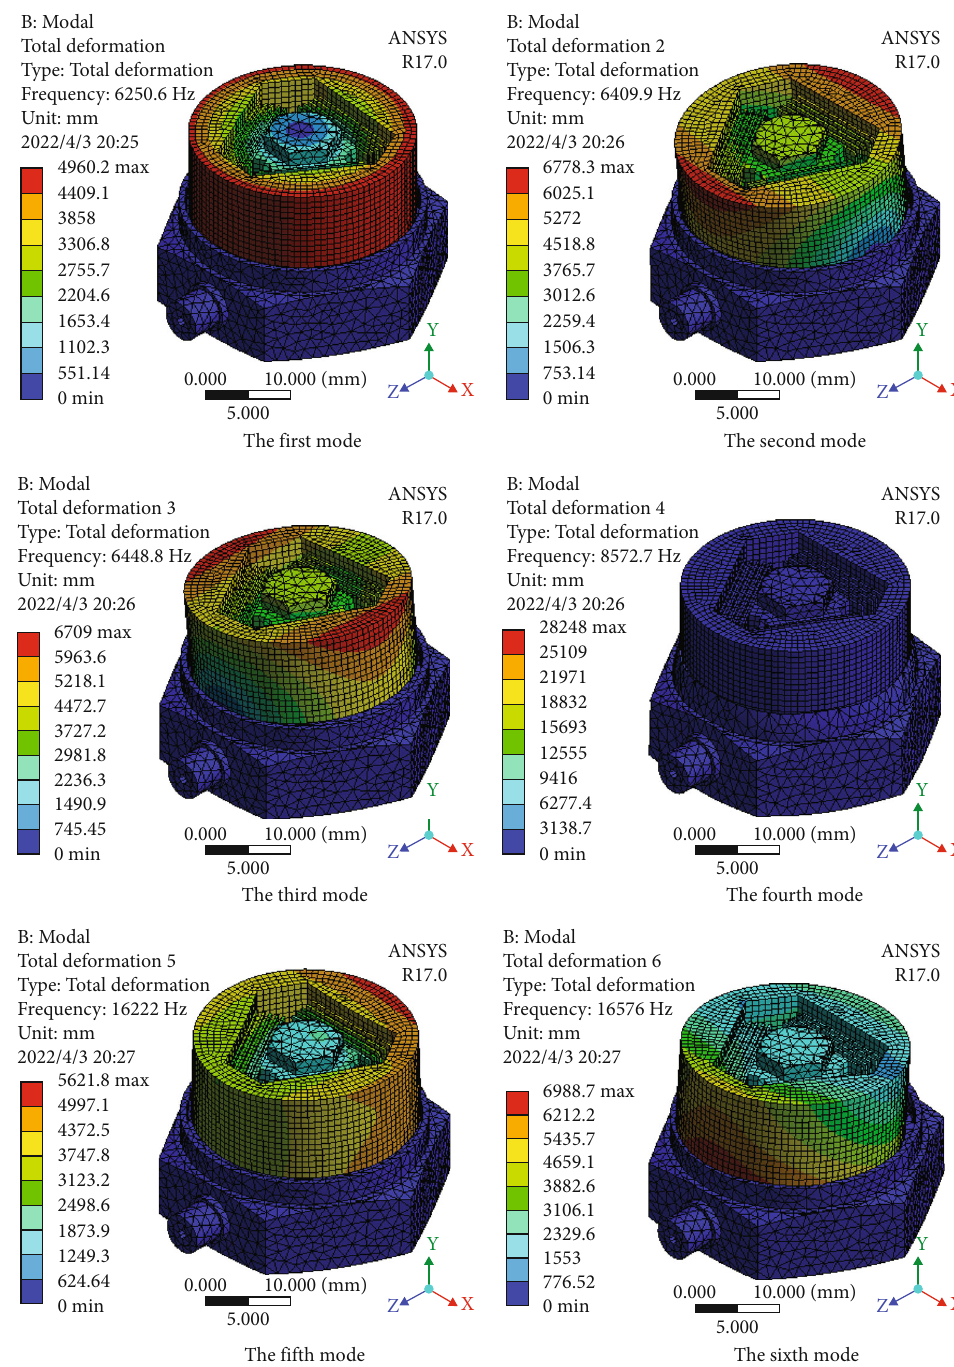
Figure 6: The fi rst to sixth vibration